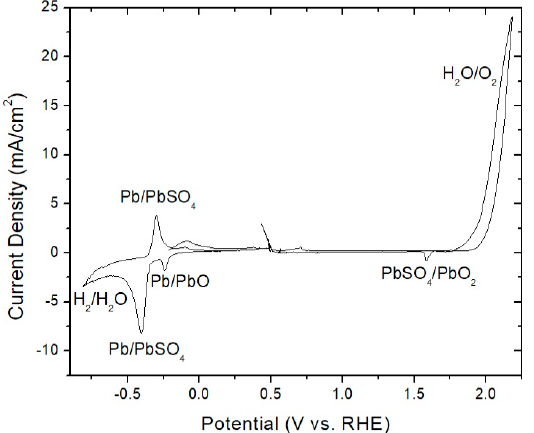
Figure 1. Cyclic voltammogram of a PbAg anode in 1.6 M H 2 SO 4 with relevant redox features labeled, scan rate 5 mV·s − 1 .